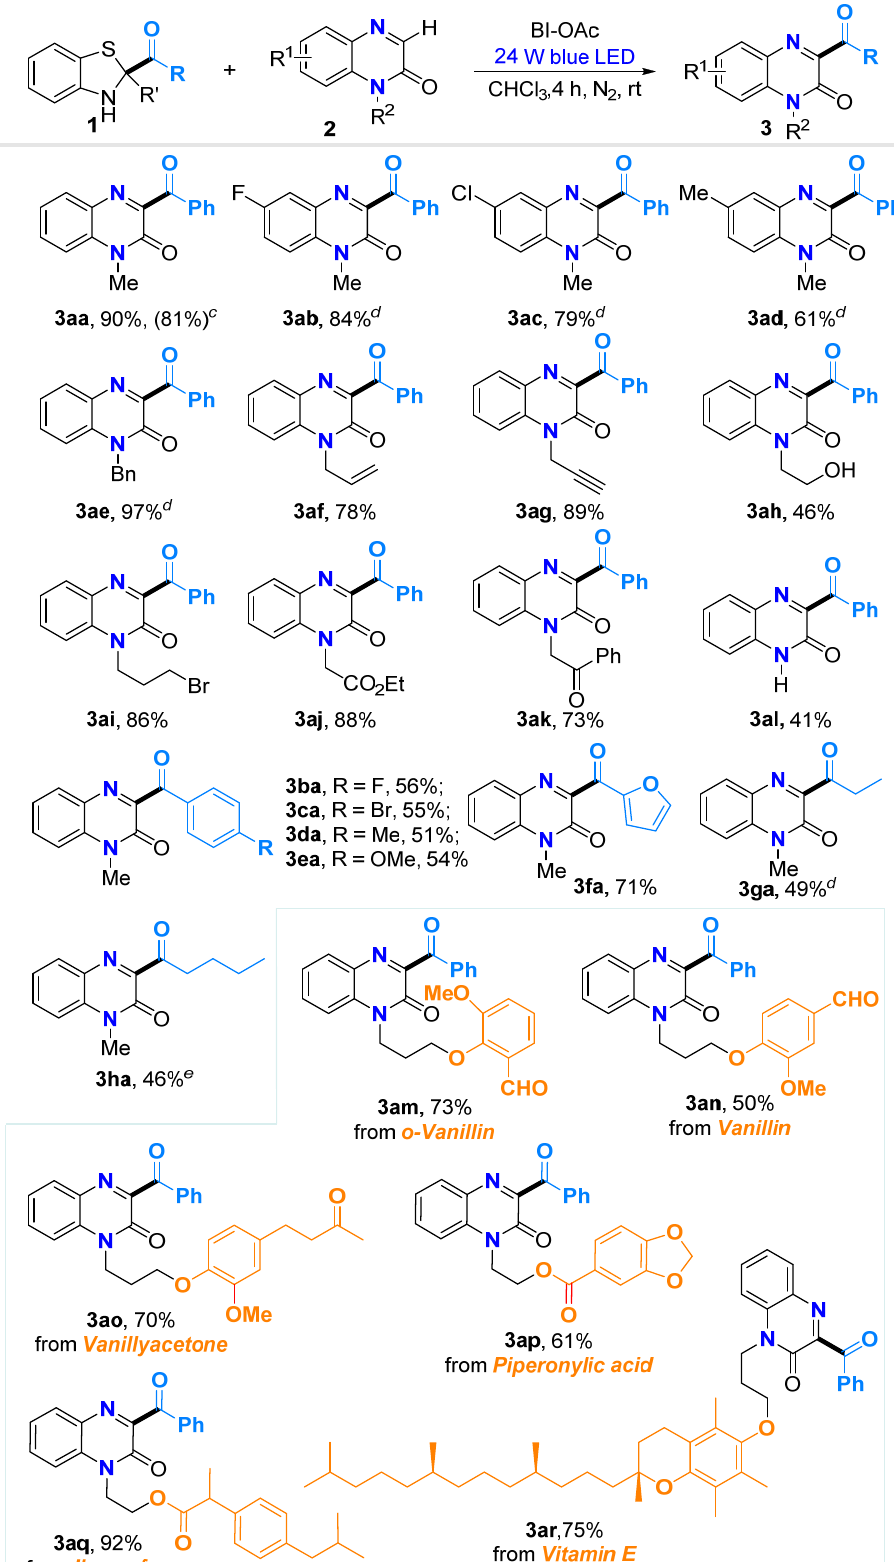
Scheme 2. Reaction scope of C(3)-H acylation of quinoxaline-2(1H)-ones a,b . a Reaction conditions: 1 (0.24 mmol), 2 (0.2 mmol) and BI-OAc (0.24 mmol) in CHCl 3 (2.0 mL), irradiation by 24 W blue LED at room temperature for 4 h under N 2 atmosphere. b Isolated yield. c 7 mmol scale, 5 h. d 7 h. e 6